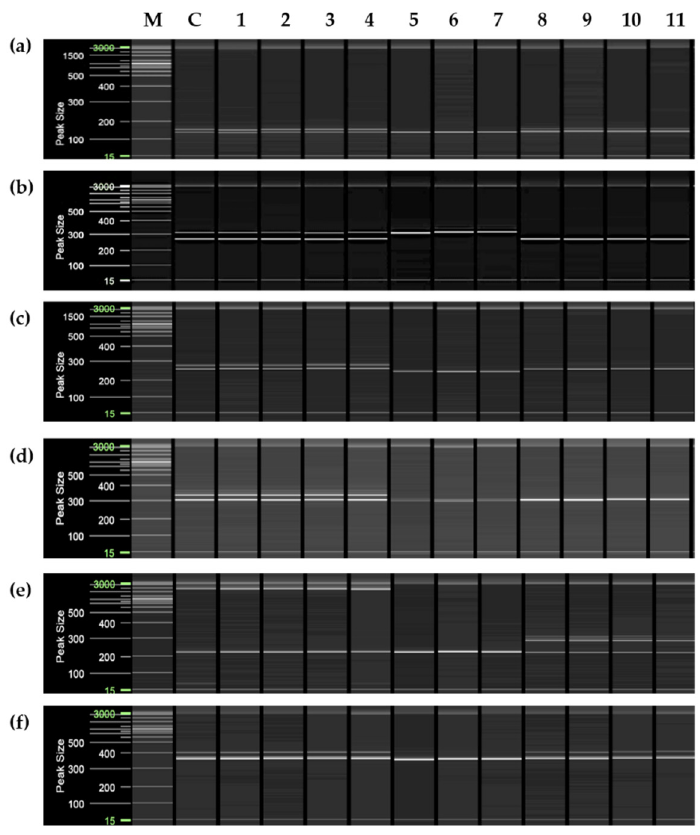
Figure 2. Molecular analysis of simple sequence repeat (SSR) marker in control and regenerated plants obtained from the anther culture. Polymerase chain reaction was performed using the following primers: ( a ) BM-CiSSR-P1; ( b ) BM-CiSSR-43; ( c ) BM-CiSSR-226; ( d ) BM-CiSSR-246; ( e ) BM-CiSSR-254; and ( f ) BM-CiSSR-260. M, molecular marker (20 and 100 bp DNA ladder); C, control plant; lanes 2–11, regenerated plants obtained using anther culture.